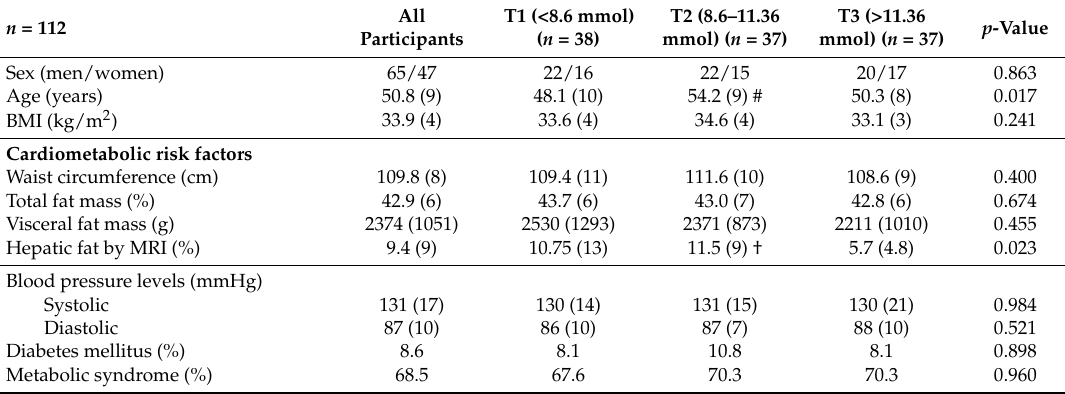
Table 1. Descriptive characteristics of the study participants according to tertiles of total antioxidant capacity